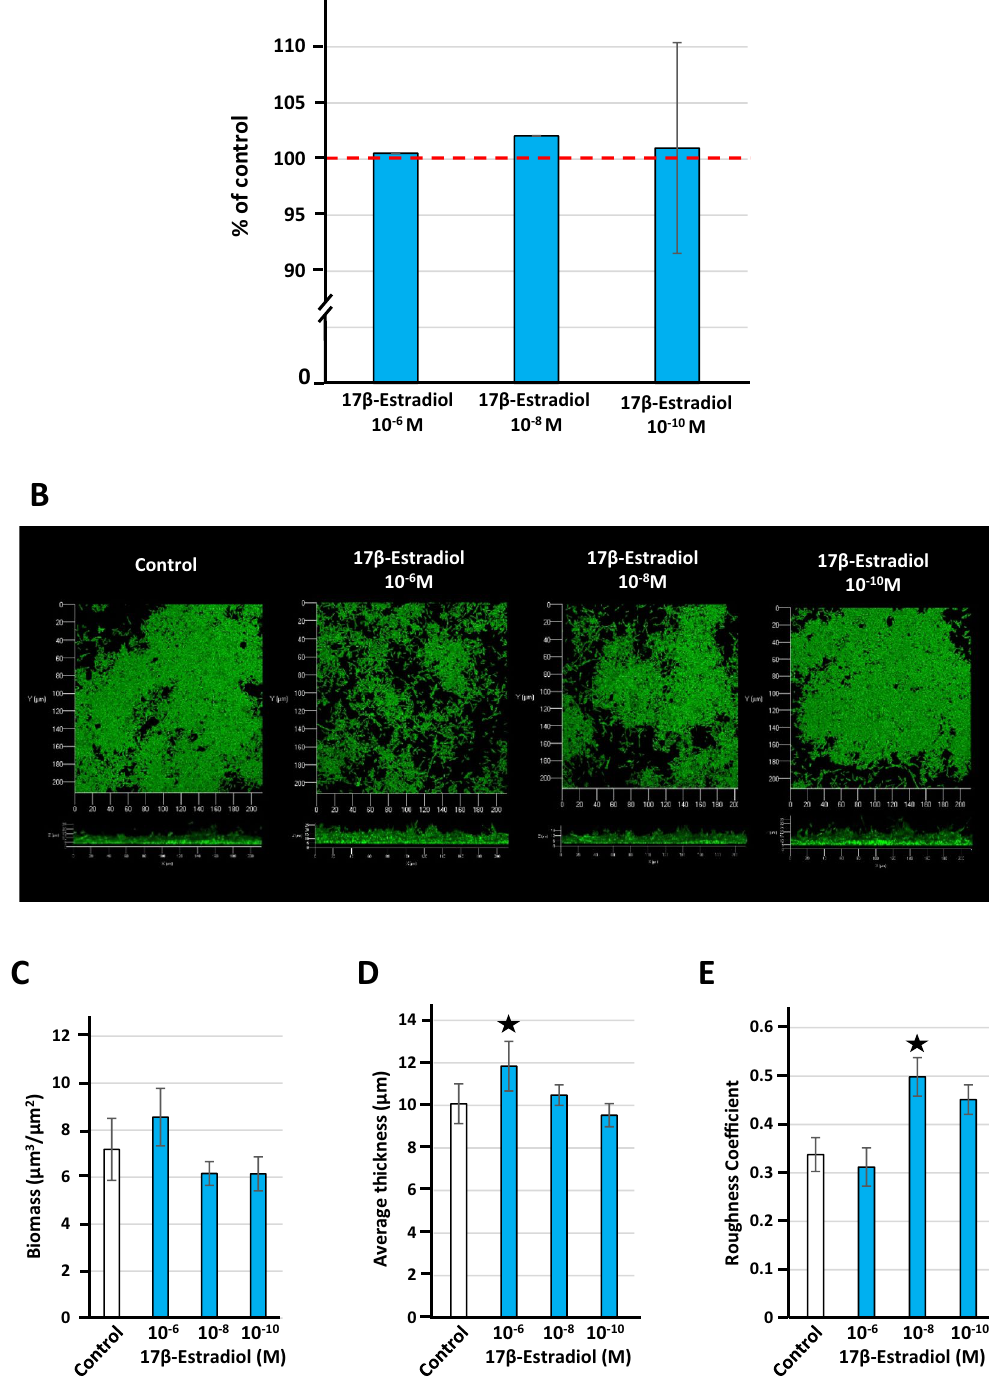
Figure 8. Effect of 17β-estradiol (10 –6 , 10 –8 , or 10 –10 M) on biofilm formation of Lactobacillus crispatus V4. ( A ) Biofilm formation of bacteria grown in MRS medium, with or without 17β-estradiol, studied by the crystal violet staining assay. ( B ) Structure of the Lactobacillus crispatus CIP104459 biofilm formed in “simulating genital tract secretion” (SGTS) medium and visualized by confocal laser scanning microscopy. All figures are represented at the same scale and show top (X/Y) and lateral (X/Z mean thickness) views of the biofilms formed. Effect of 17β-estradiol on the calculated means biofilm biomass ( C ), thickness ( D ) and roughness ( E ). Results are representative of three independent experiments ( p < ★